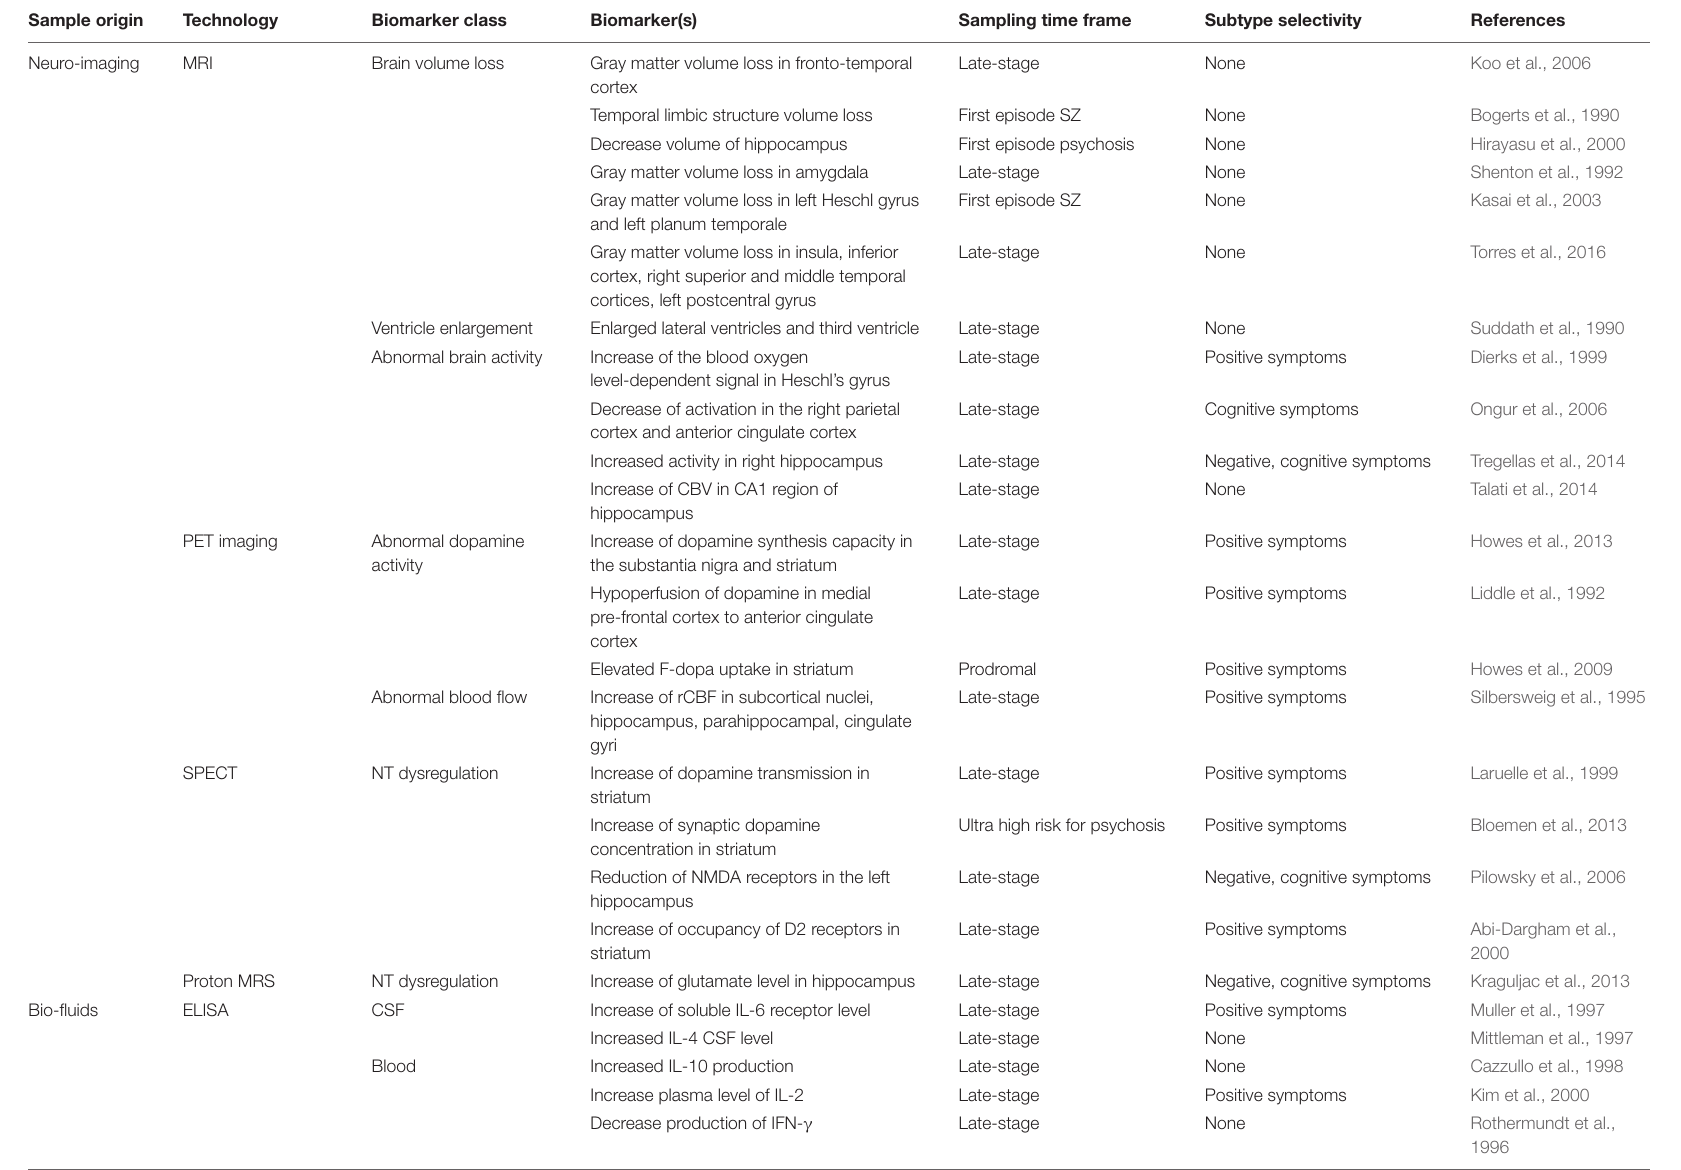
TABLE 1 | Selected reports hinting potential schizophrenic